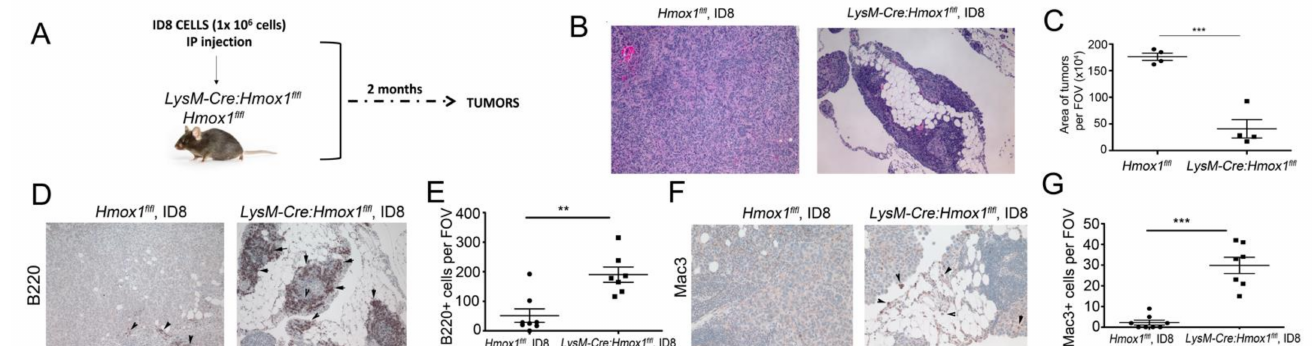
Figure 6. Lack of HO-1 in macrophages ( LysM-Cre:Hmox1 flfl mice) suppresses growth of ID8 tumors in metastatic model of ovarian cancer. ( A ) Scheme showing the experimental design. ( B ) Representative H&E staining of ID8 tumors growing in the peritoneum of Hmox1 or LysM-Cre:Hmox1 flfl mice and harvested at 8 weeks after inoculation. Magnification 200x. ( C ) Quantification of the size of the tumors based on the histology. N = 4-5 mice/group. *** p < 0.001. ( D – G ) IHC analyses of ID8 tumors examined as in Figure 1 and stained with antibodies against B220 ( D , E ) or Mac3 ( F , G ). Magnification 200x. The representative sections are shown in ( D , F ) and quantification is shown in ( E , G ). ** p < 0.01, *** p <